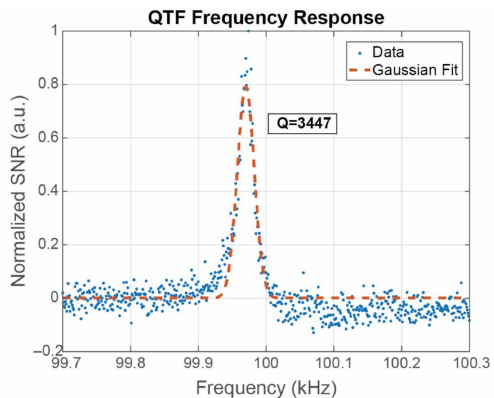
Figure 5. Frequency response of the Quartz Tuning Fork and the sensor’s Q